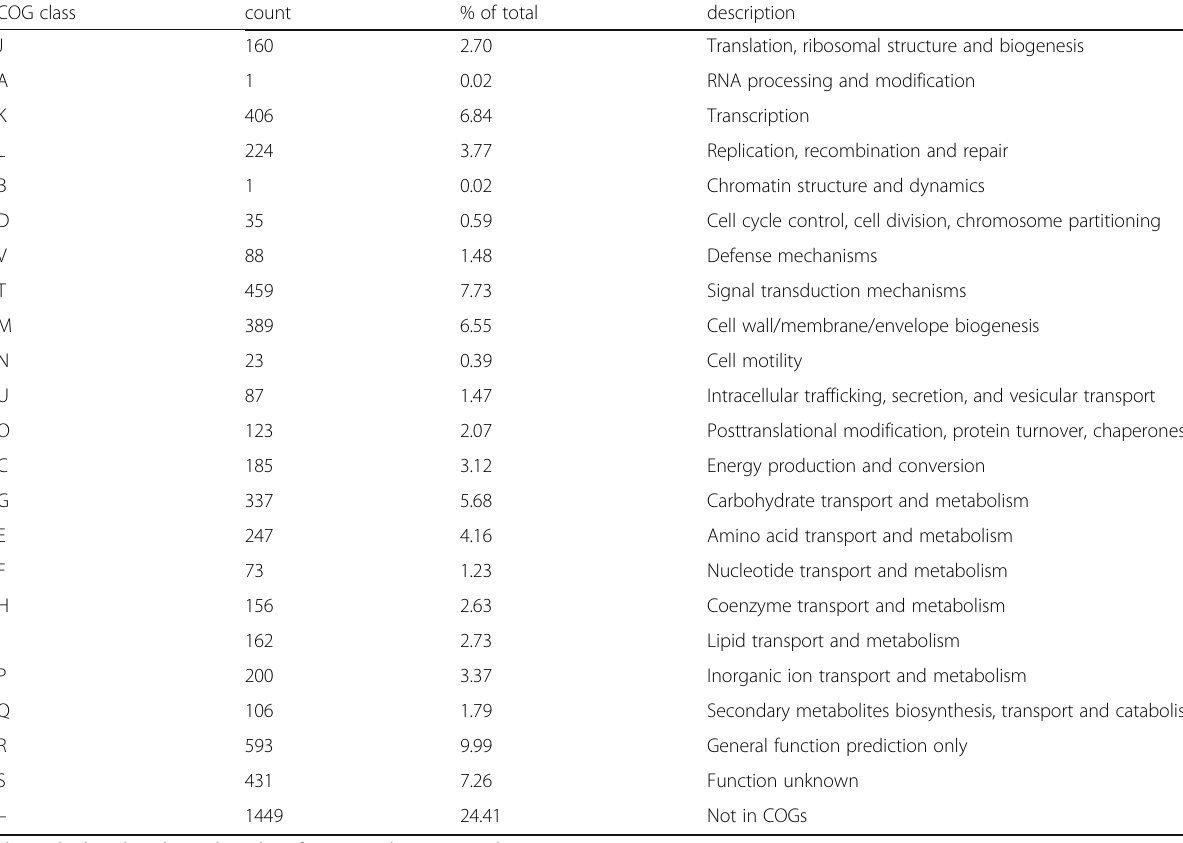
Table 4 Number of genes associated with the 21 general COG functional categories COG class